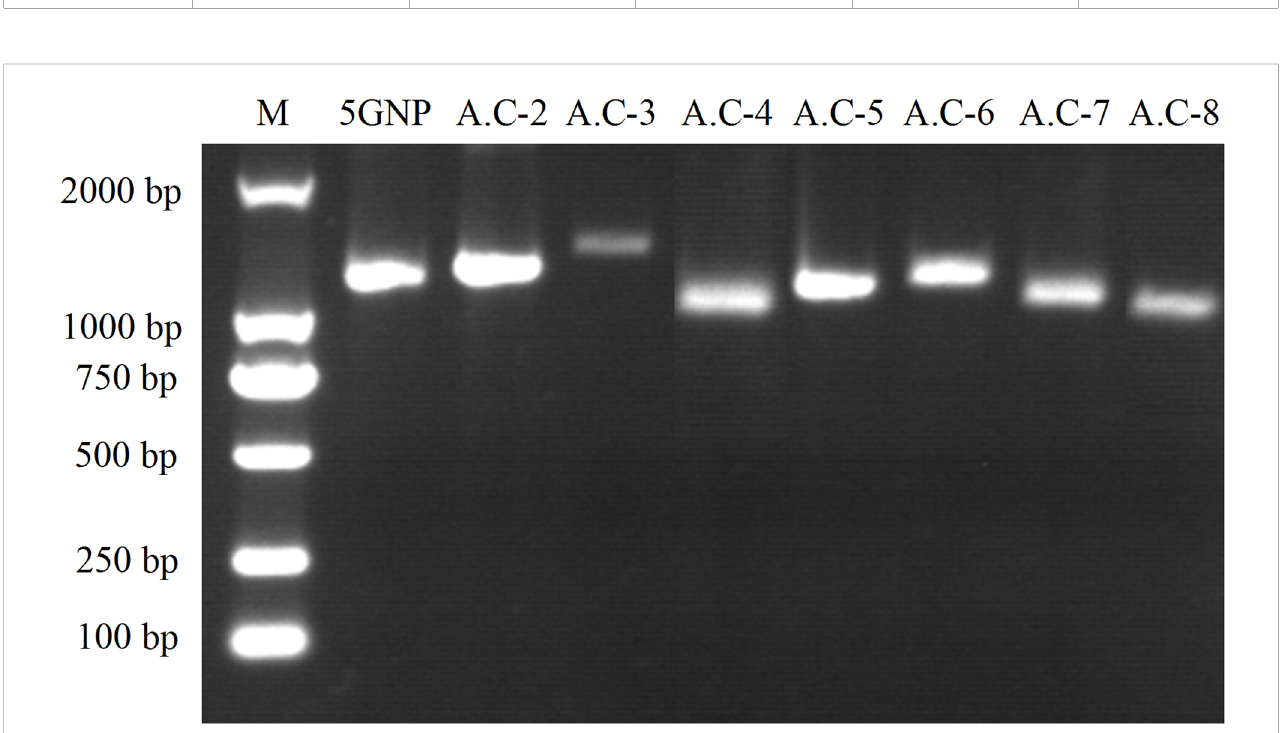
FIGURE 2 PCR ampli fi cation results for ACCase cDNA sequences. Eight primer pairs were designed based on homologous sequence comparison to amplify ACCase cDNA sequences via PCR and RACE. The sizes of the target fragments were 1,265, 1,304, 1,448, 1,136, 1,144, 1,232, 1,130, and 1,124 bp. The abbreviations above the image represent corresponding primers and the numbers on the left-hand side of the image indicate the size of DNA